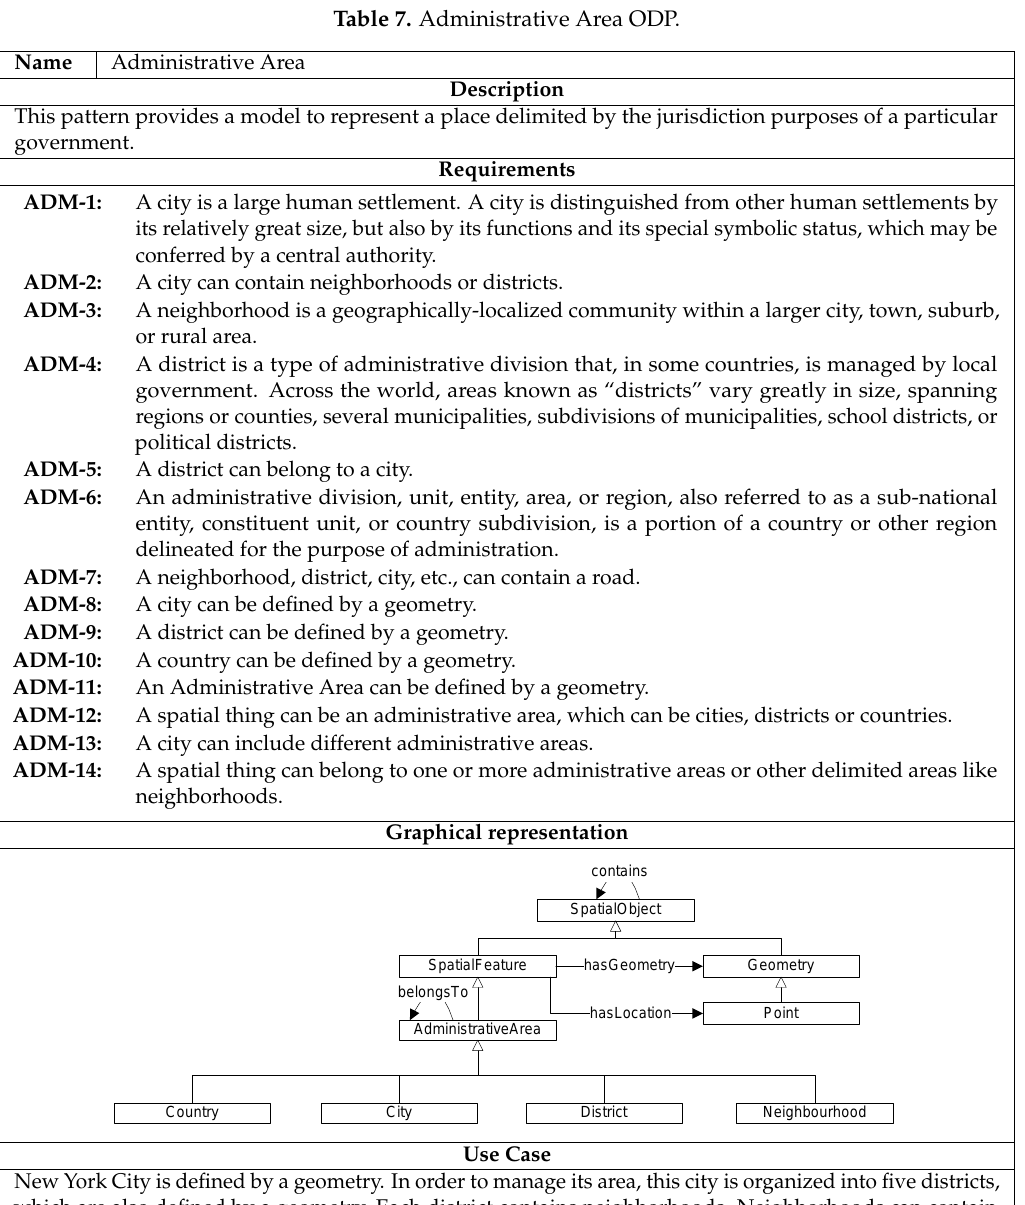
Table 7. Administrative Area